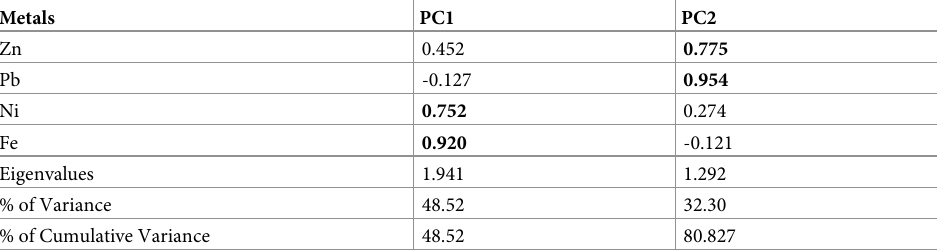
Table 4. Rotated component matrix of heavy